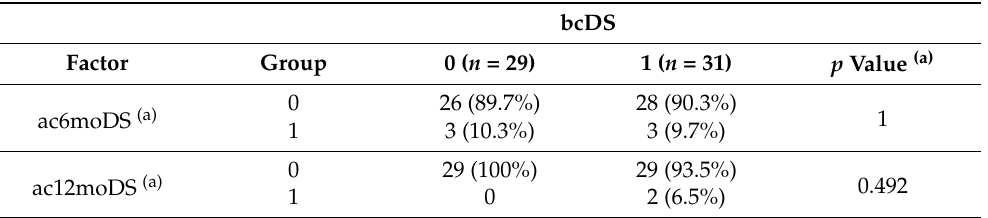
Table 2. Dual-staining p16/Ki-67 before conization (bcDS) at 6 (ac6moDS) and 12 months after conization